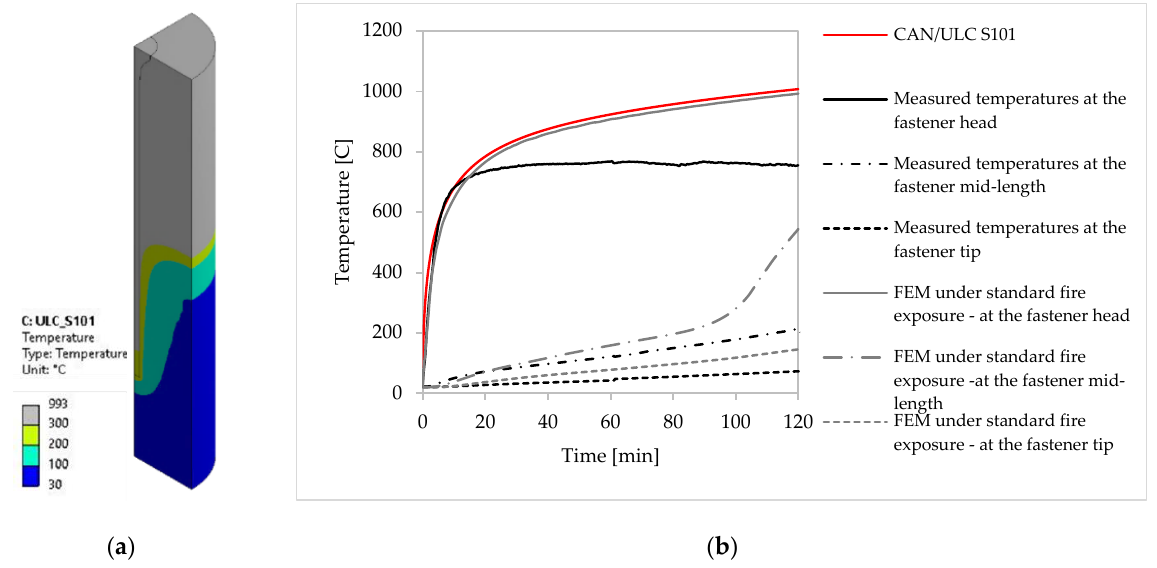
Figure 16. Numerical modelling of Ø 10 mm full-thread screws under standard fire CAN/ULC S101 [6]: ( a ) Heat transfer model at two hours of fire exposure; ( b ) Comparison of numerical and experiment of time–temperature curves up to two hours of fire exposure.